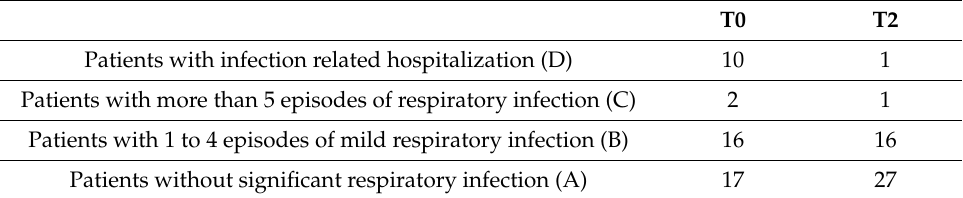
Table 3. Patients subdivided by number and severity of respiratory infections at T0 and T2. T0 T2 Patients with infection related hospitalization (D) 10 1 Patients with more than 5 episodes of respiratory infection (C) 2 1 Patients with 1 to 4 episodes of mild respiratory infection (B) 16 16 Patients without significant respiratory infection (A) 17